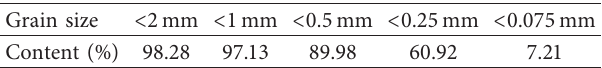
Table 4: Grain size distribution of iron tailing sand. Grain size